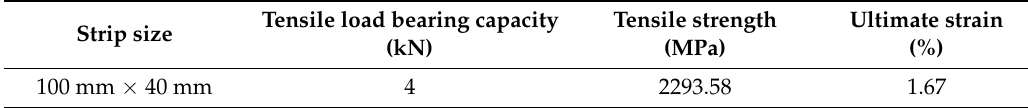
Table 2. Mechanical properties of carbon textile strip.